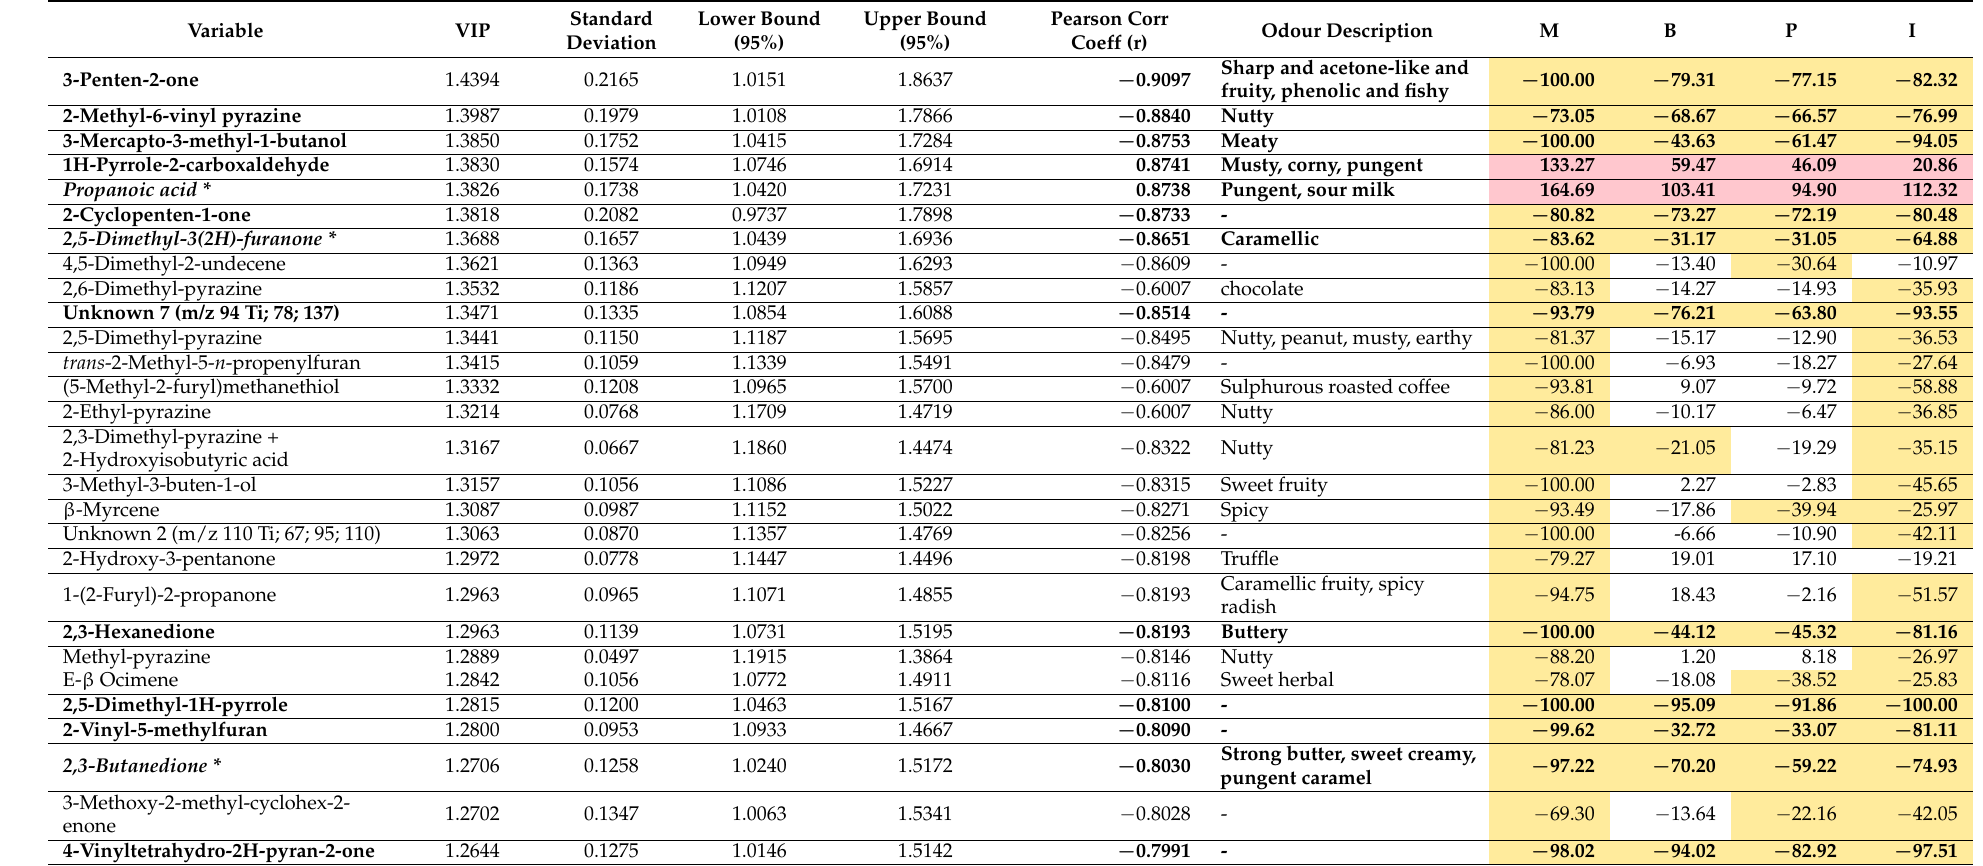
Table 2. VIP from PLS-DA (variable important in the projection) > 1 in describing oxidised samples, volatile standard deviation and boundaries at a 95% confidence limit, Pearson correlation coefficient (r), and the description of the odour quality together with the compound CV% in the different blends/packagings, presented in conditional format, is reported (in yellow, CV% < − 20, and in red, CV% > 20). Volatiles that decrease or increase in amount in all blends/packagings are indicated in bold; known volatiles from the literature that are related to staling are indicated in italics, while those that display different trends in comparison with literature data are indicated by